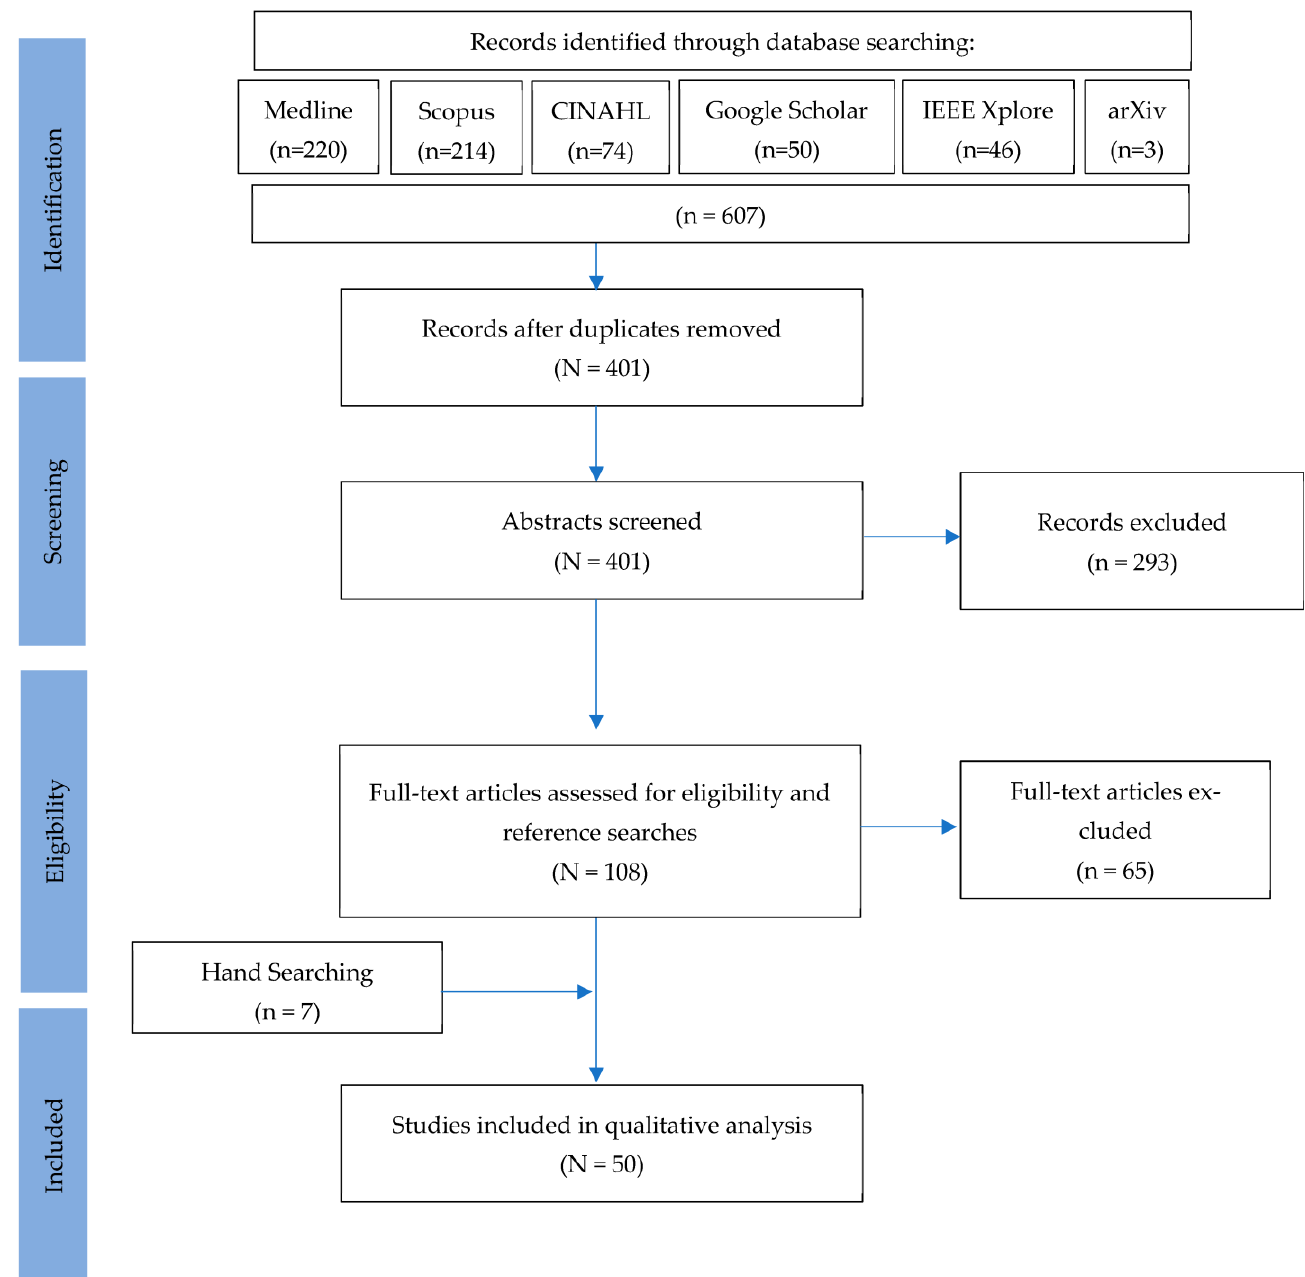
Figure 2. Study selection flowchart.